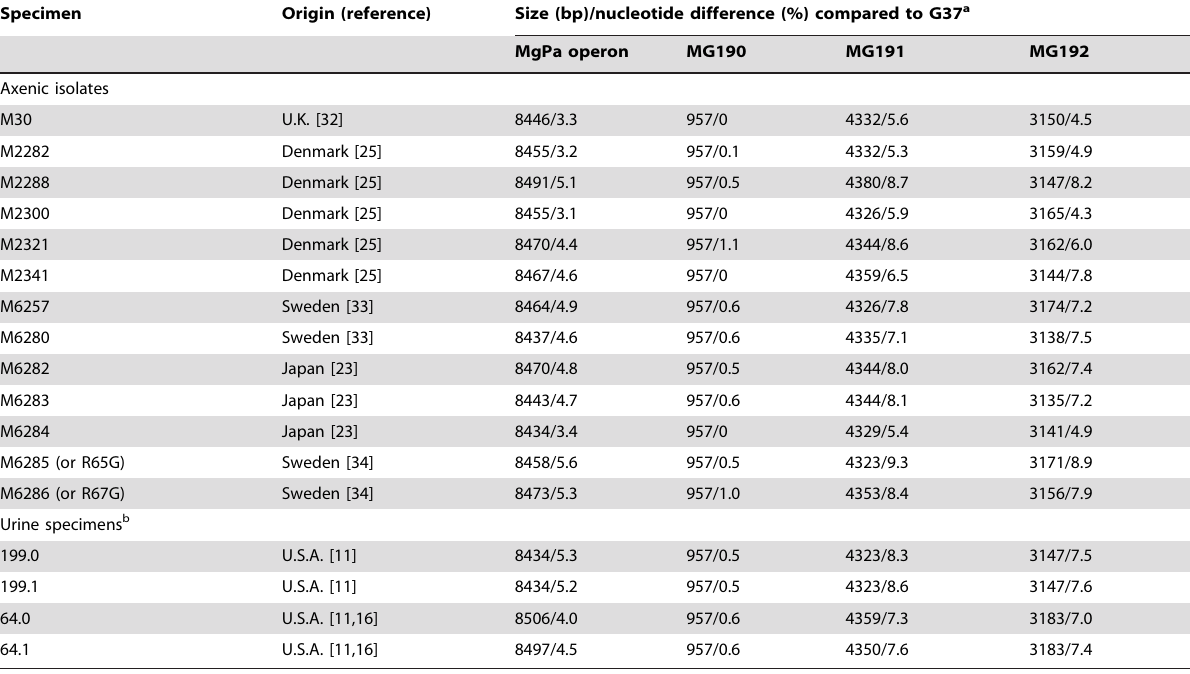
Table 1. Sequence variation of the MgPa operon among M. genitalium axenic isolates and urine specimens.